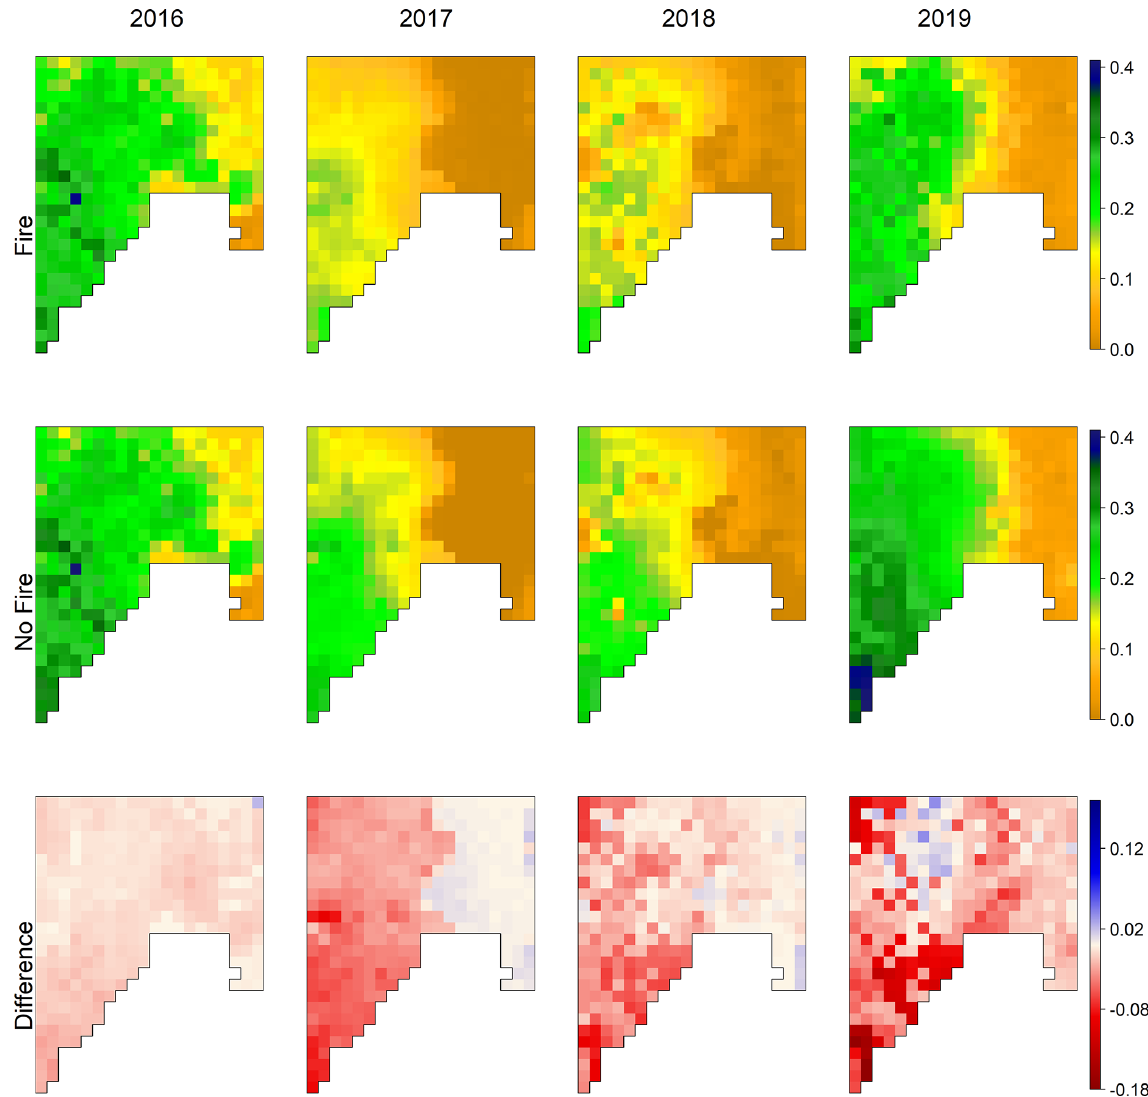
Figure 4. EDv2.2-predicted mean monthly GPP (kgCm − 2 yr − 1 ) for the Soda Fire scenario for July, showing outputs from the model with fire (upper row) and without fire (middle row), and the difference between the two scenarios for the years 2016 to 2019 (representing post-fire years after the Soda